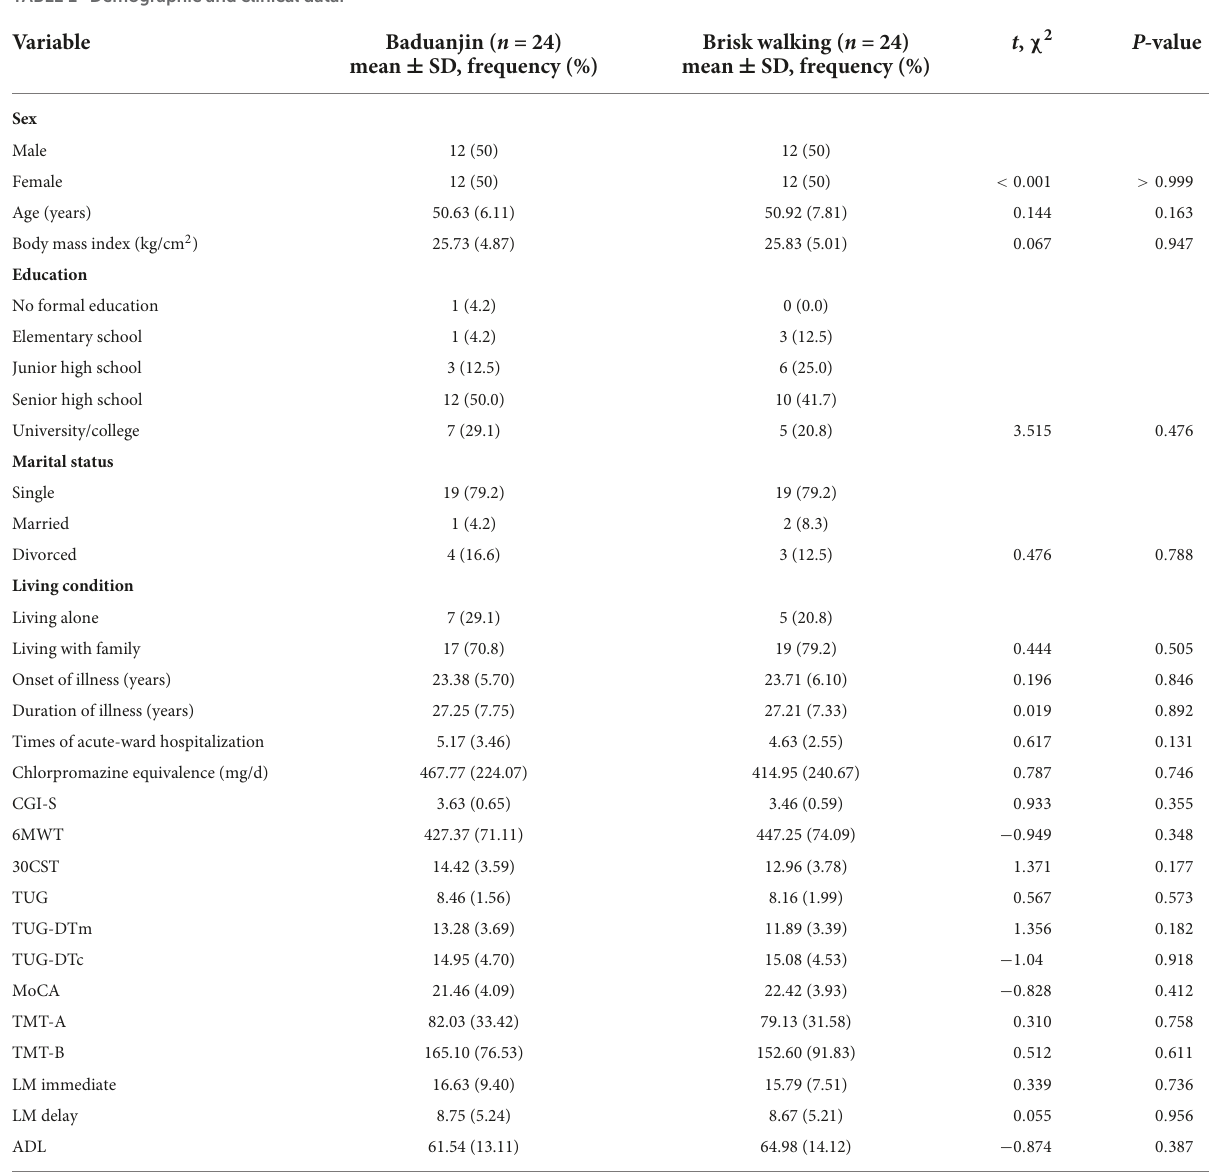
TABLE 1 Demographic and clinical